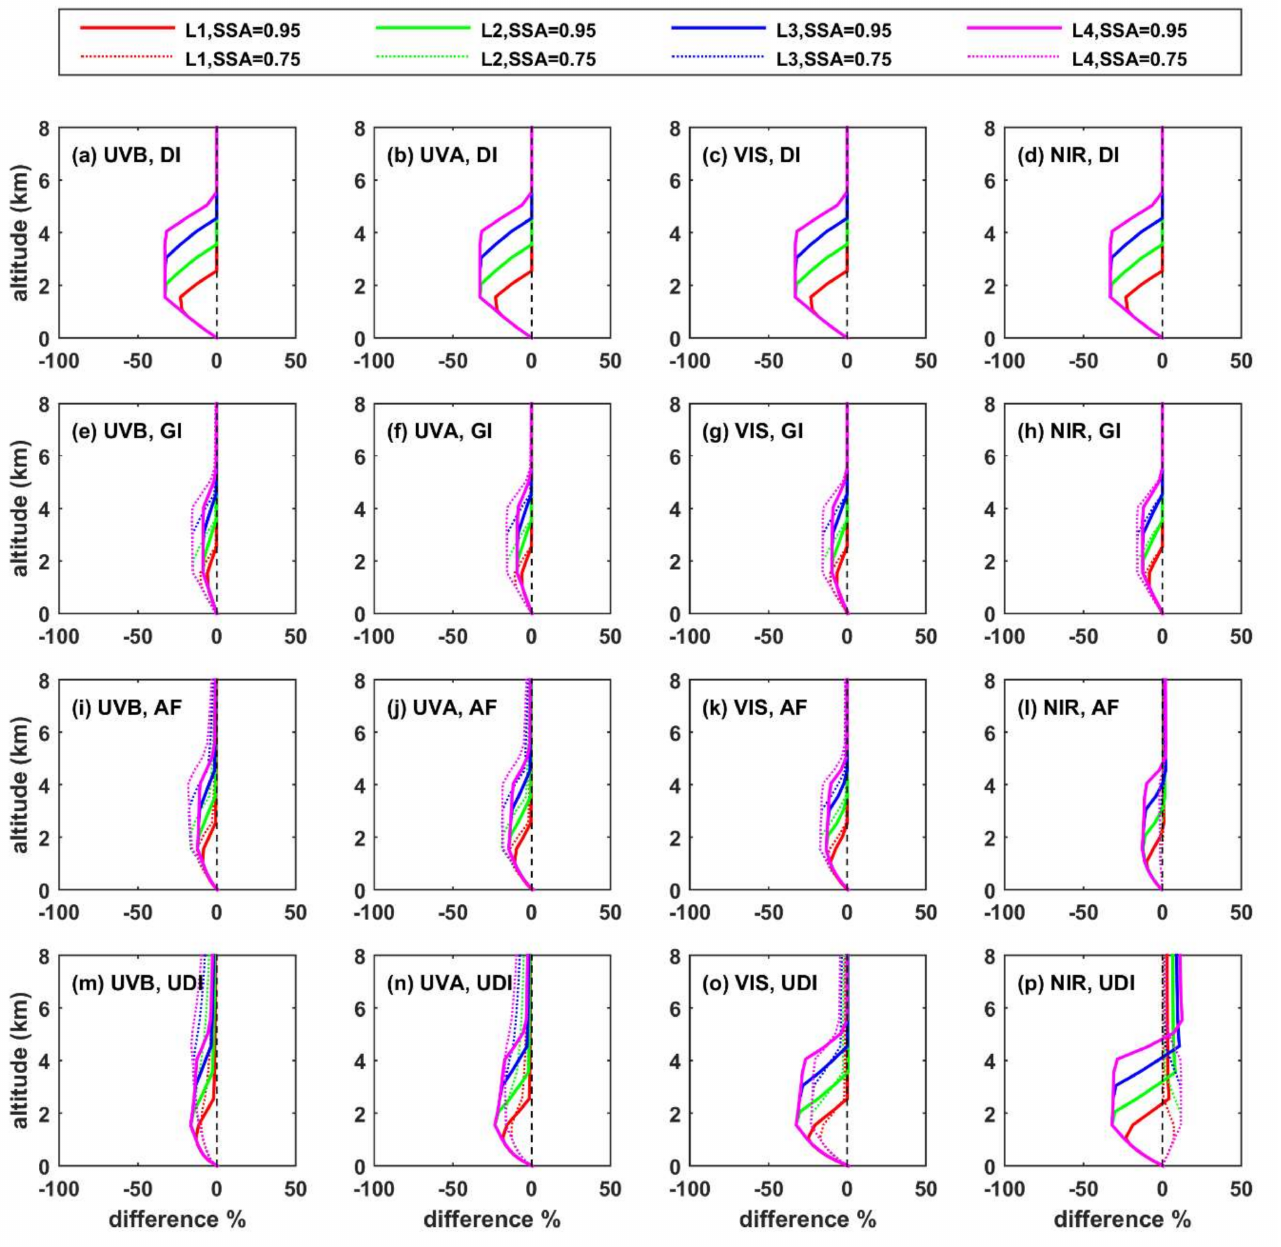
Figure A1. Same as Figure 3, but for AOD = 0.2 instead of AOD =